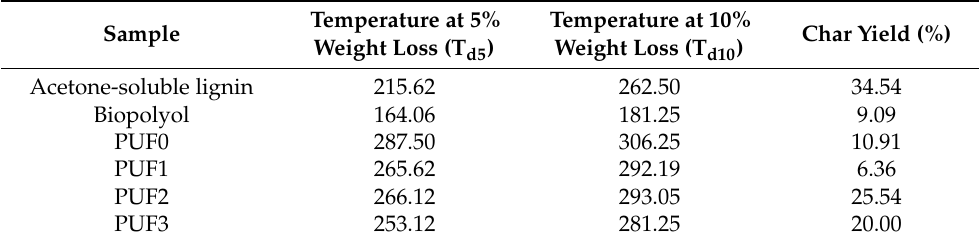
Table 2. Thermal properties of acetone-soluble lignin of silvergrass saccharification residue, optimal biopolyol, and synthesized polyurethane